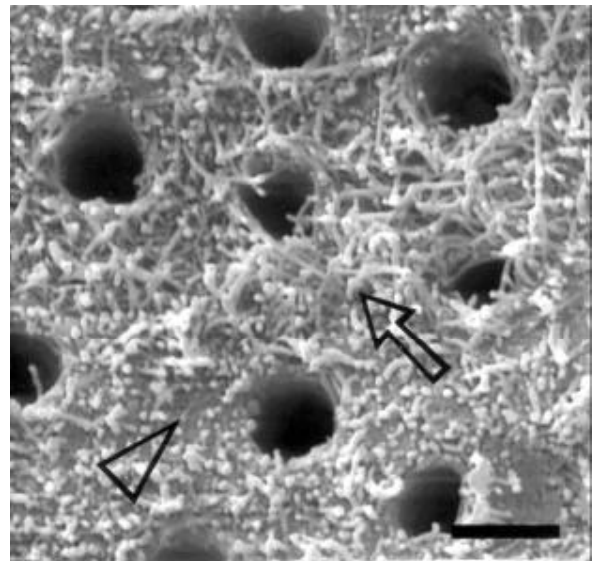
FIGURE 3 - Cross-sectioned tubules showing exposed outer peritubular (arrow) and intertubular collagen fibrils (arrowhead) for a tooth from a 29 year-old patient (Bar = 1 µm / 10,000 X)